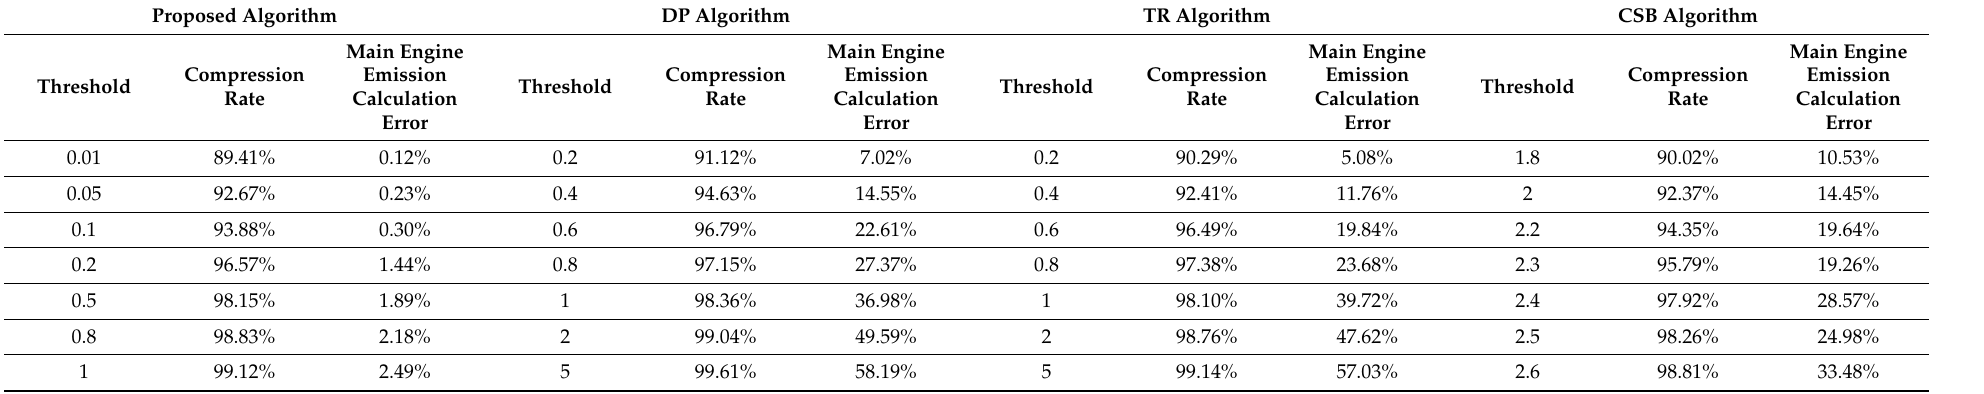
Table 3. Partial performance comparison of each compression algorithm under different thresholds (Ningbo Port